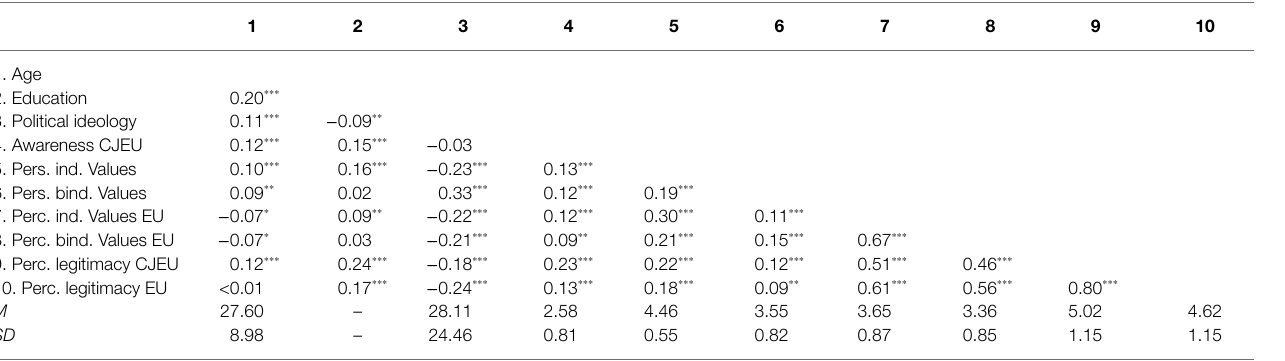
TABLE 1 | Descriptive statistics and Pearson correlations between study